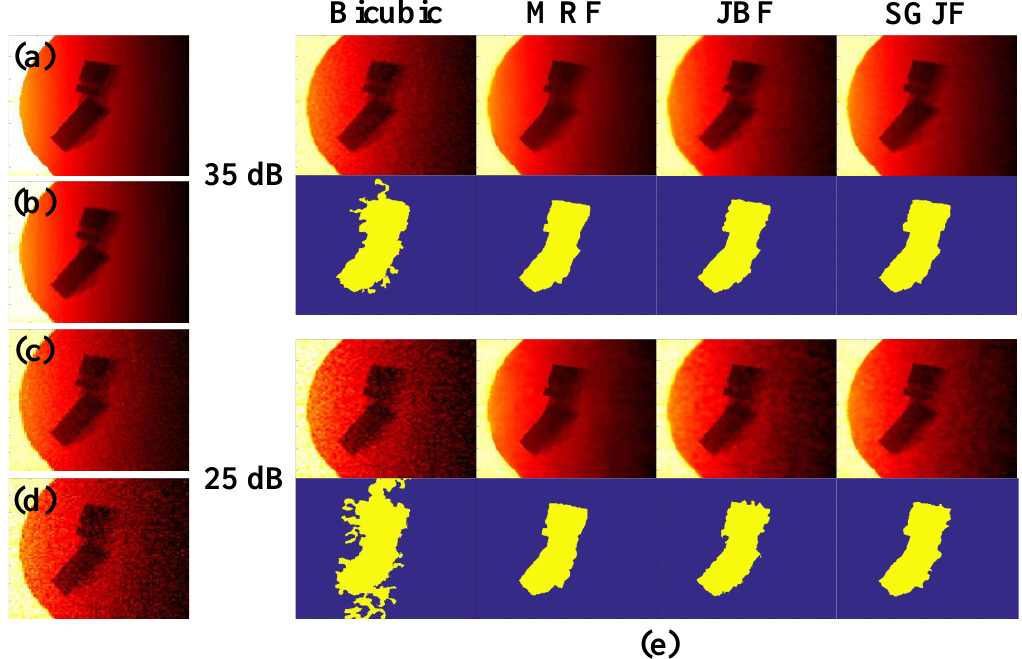
Figure 7. Explanation of the experiment phenomenon. ( a ) Original high-res range image (OHRRI). ( b ) Down-sampled image at 𝑑 = 4 . ( c ) ( b ) with 35 dB noise. ( d ) ( b ) with 25 dB noise. ( e ) Super-resolved images of ( c ) and ( d ) and their binary images.